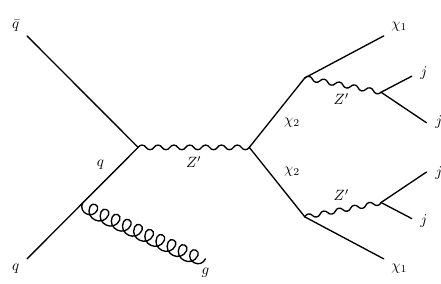
Figure 2 . Illustrative Feynman diagram for the displaced vertex process of interest, including the decay of (cid:31) 2 . Initial state can also be quark-gluon with an ISR quark